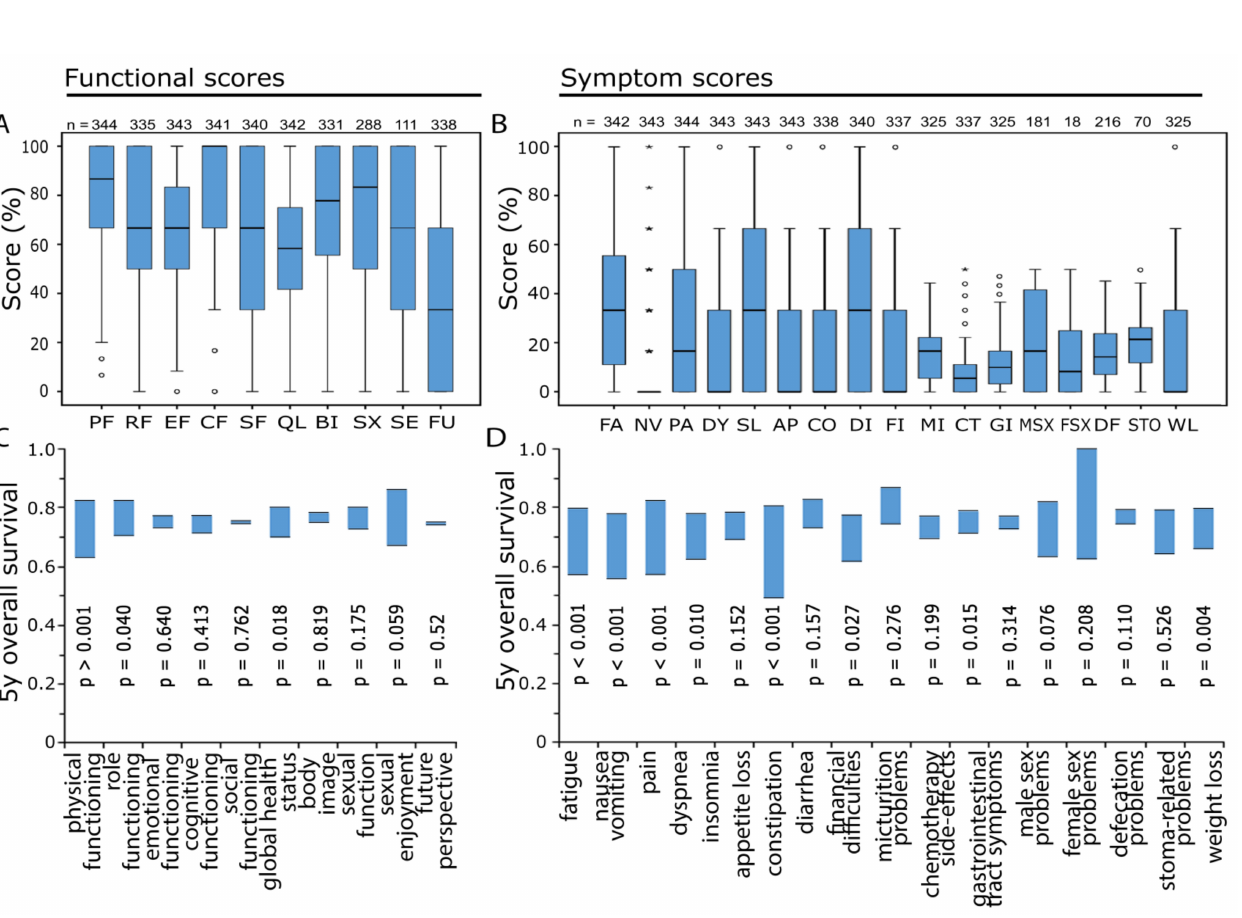
Figure 2. ( A ) Value distribution at day -1 for all functional scores, physical functioning (PF), role functioning (RF), emotional functioning (EF), cognitive functioning (CF), social functioning (SF), global health status (QL), body image (BI), sexual function (SX), sexual enjoyment (SE), future perspective (FU). ( B ) Result distribution at baseline for all symptom scores, fatigue (FA), nausea and vomiting (NV), pain (PA), dyspnea (DY), insomnia (SL), appetite loss (AP), constipation (CO), diarrhea (DI), financial difficulties (FI), micturition problems (MI), chemotherapy side effects (CT), gastrointestinal tract symptoms (GI), male sex problems (MSX), female sex problems (FSX), defecation problems (DF), stoma-related problems (STO), weight loss (WL). ( C ) Five-year survival rate in the Kaplan-Meier analysis of the groups with high and low functional scores. The upper end of the bar represents the 5-year overall survival of patients with high functional scores and the lower end that of patients with low functional scores. ( D ) Five-year survival rate in the Kaplan-Meier analysis of the groups with high and low symptom scores. The upper end of the bar represents the 5-year overall survival of patients with high symptom scores and the lower end that of patients with low symptom scores. The p -values indicate differences in overall survival by the Kaplan-Meier plots and log-rank test. “ ◦ ” marks outliers and “*” marks extreme